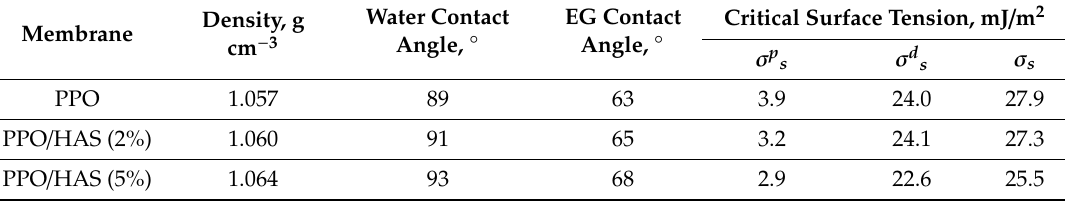
Table 1. Physical parameters of membranes.